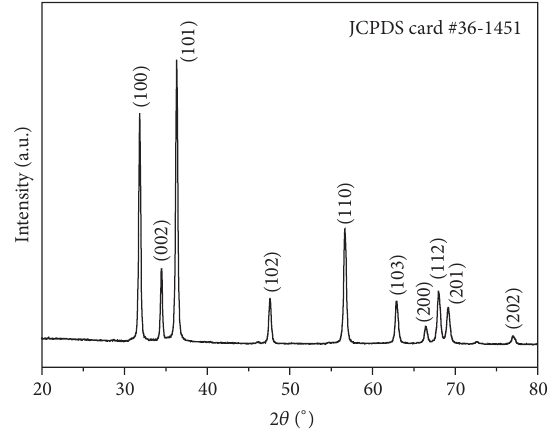
Figure 2: XRD pattern of the porous snowflake-shaped ZnO